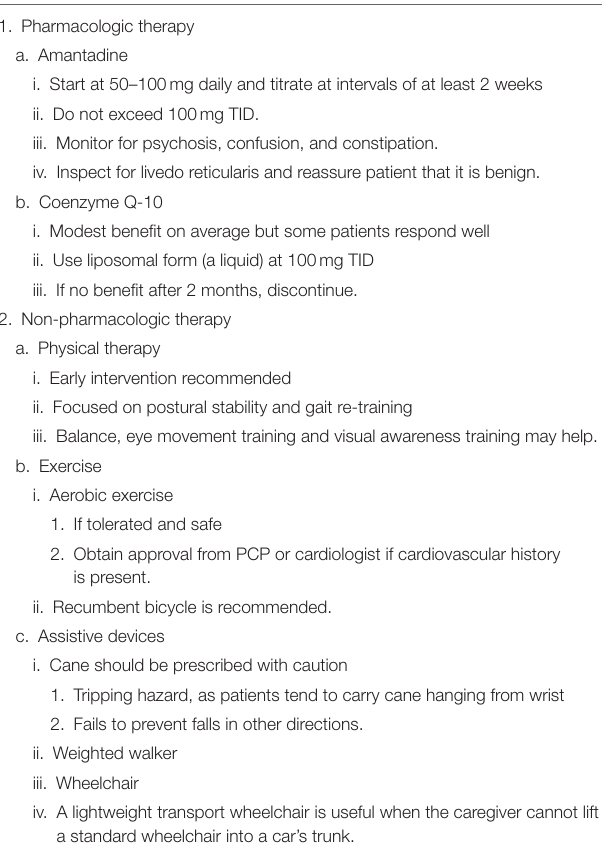
TABLE 2 | Management of gait dysfunction in